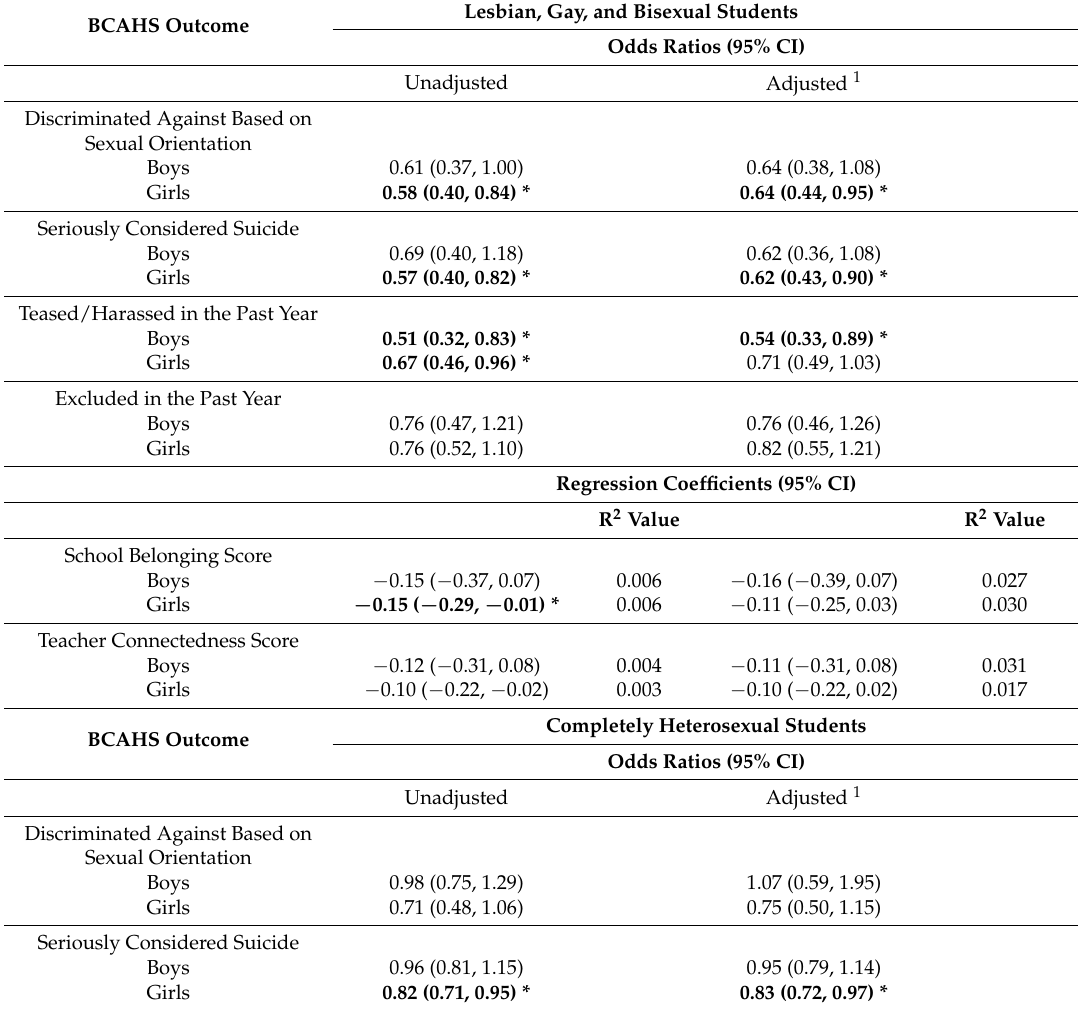
Table 3. Relationship between health outcomes among lesbian, gay, and bisexual and heterosexual students and whether a school has ever hosted an Out in Schools event. Lesbian, Gay, and Bisexual Students BCAHS Outcome Odds Ratios (95% CI) Unadjusted Adjusted